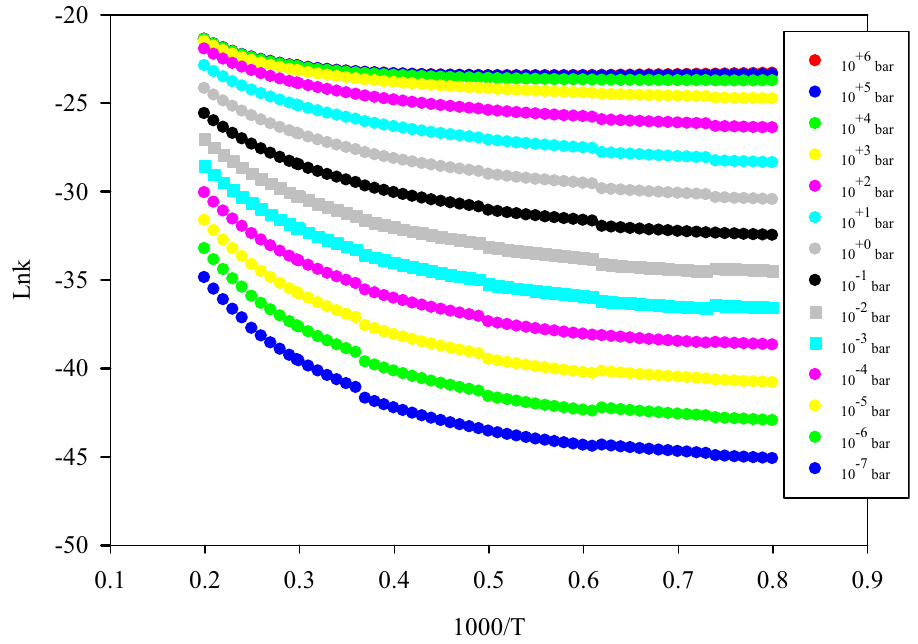
Figure 4. Representation of temperature and pressure-dependent rate constant of P1 production pathways (path 1 + path 2) of the N 2 H 4 + OH